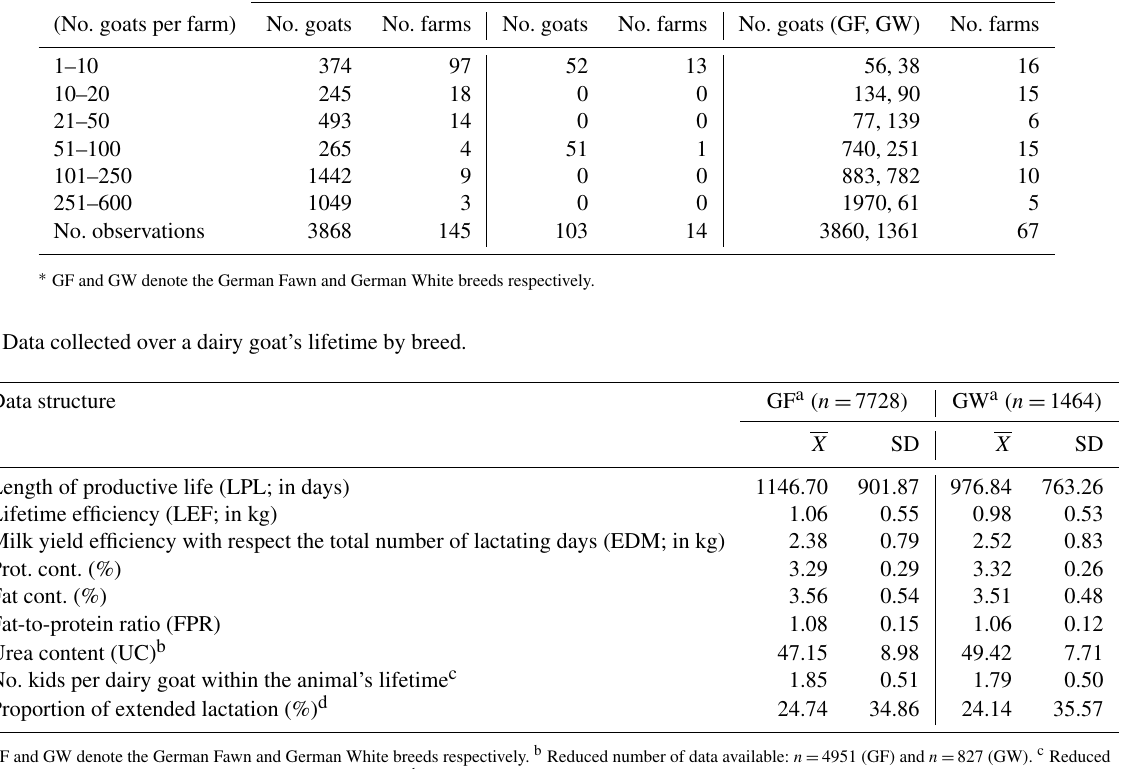
Table 1. Number of dairy goats and number of farms by breed and farm size. Farm size